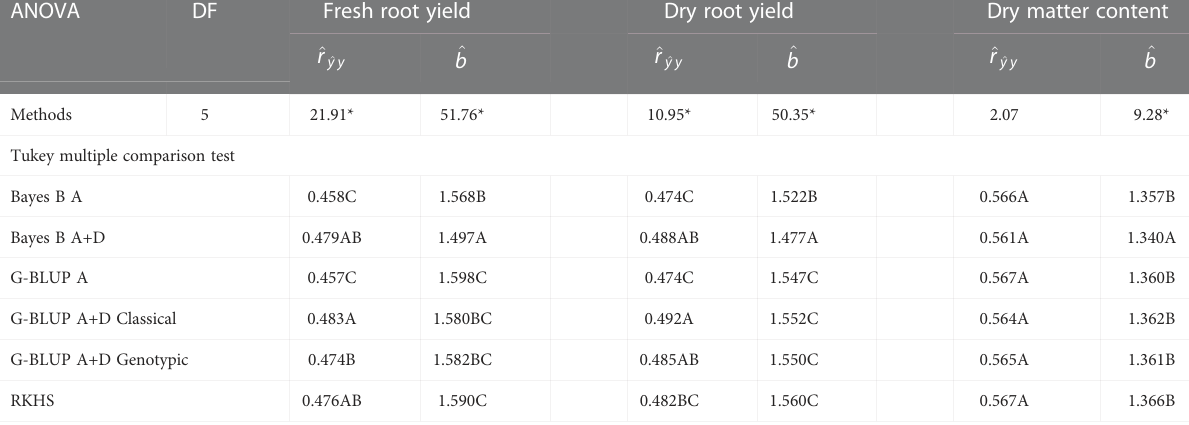
TABLE 2 Analysis of variance (ANOVA) and Tukey ’ s multiple comparison test (p ≤ 0.05) for prediction parameters of different genomic selection methods for fresh root yield (FRY), dry root yield (DRY), and dry matter content (DMC) in